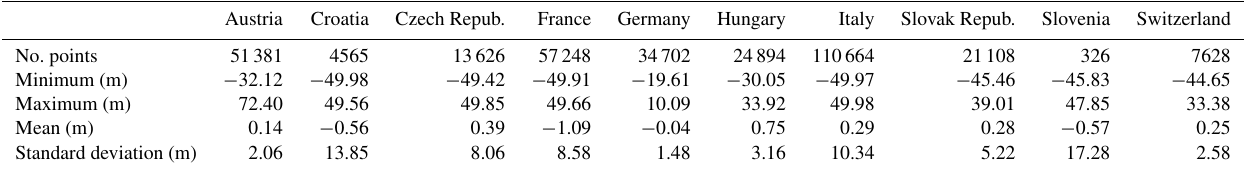
Table C2. Statistical results of test calculations of consistency of surface station heights and DEMs used of the individual countries in the “most inner zone”.